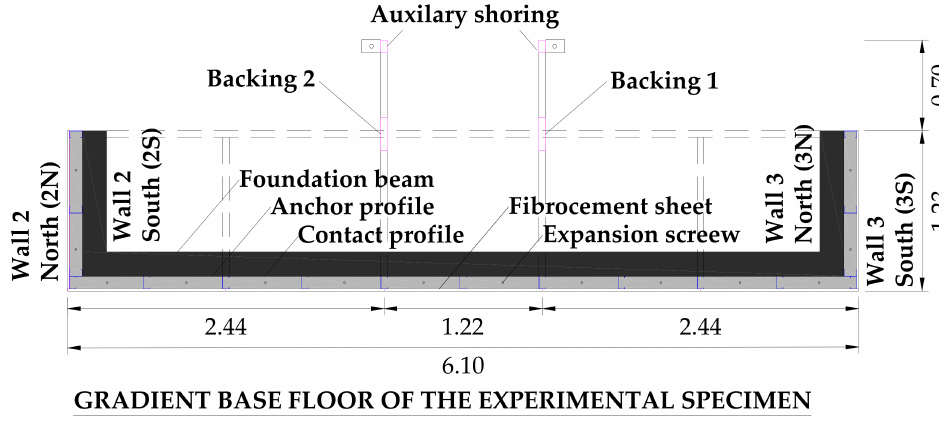
Figure 5. Gradient base floor of the experimental specimen.